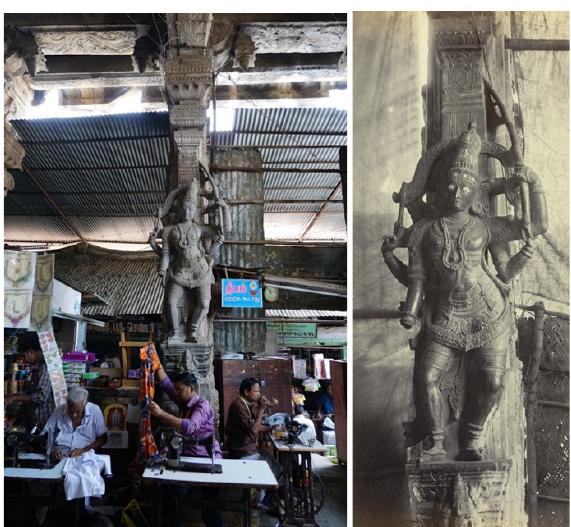
Figure 8. Left: Photograph of interior of Pudu Mandapam August 2018, (OP) and Right: Figure in Trimul Naik's Portico